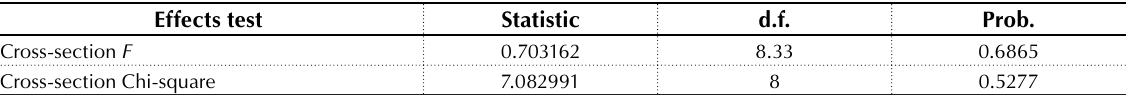
Source: Results of panel data regression